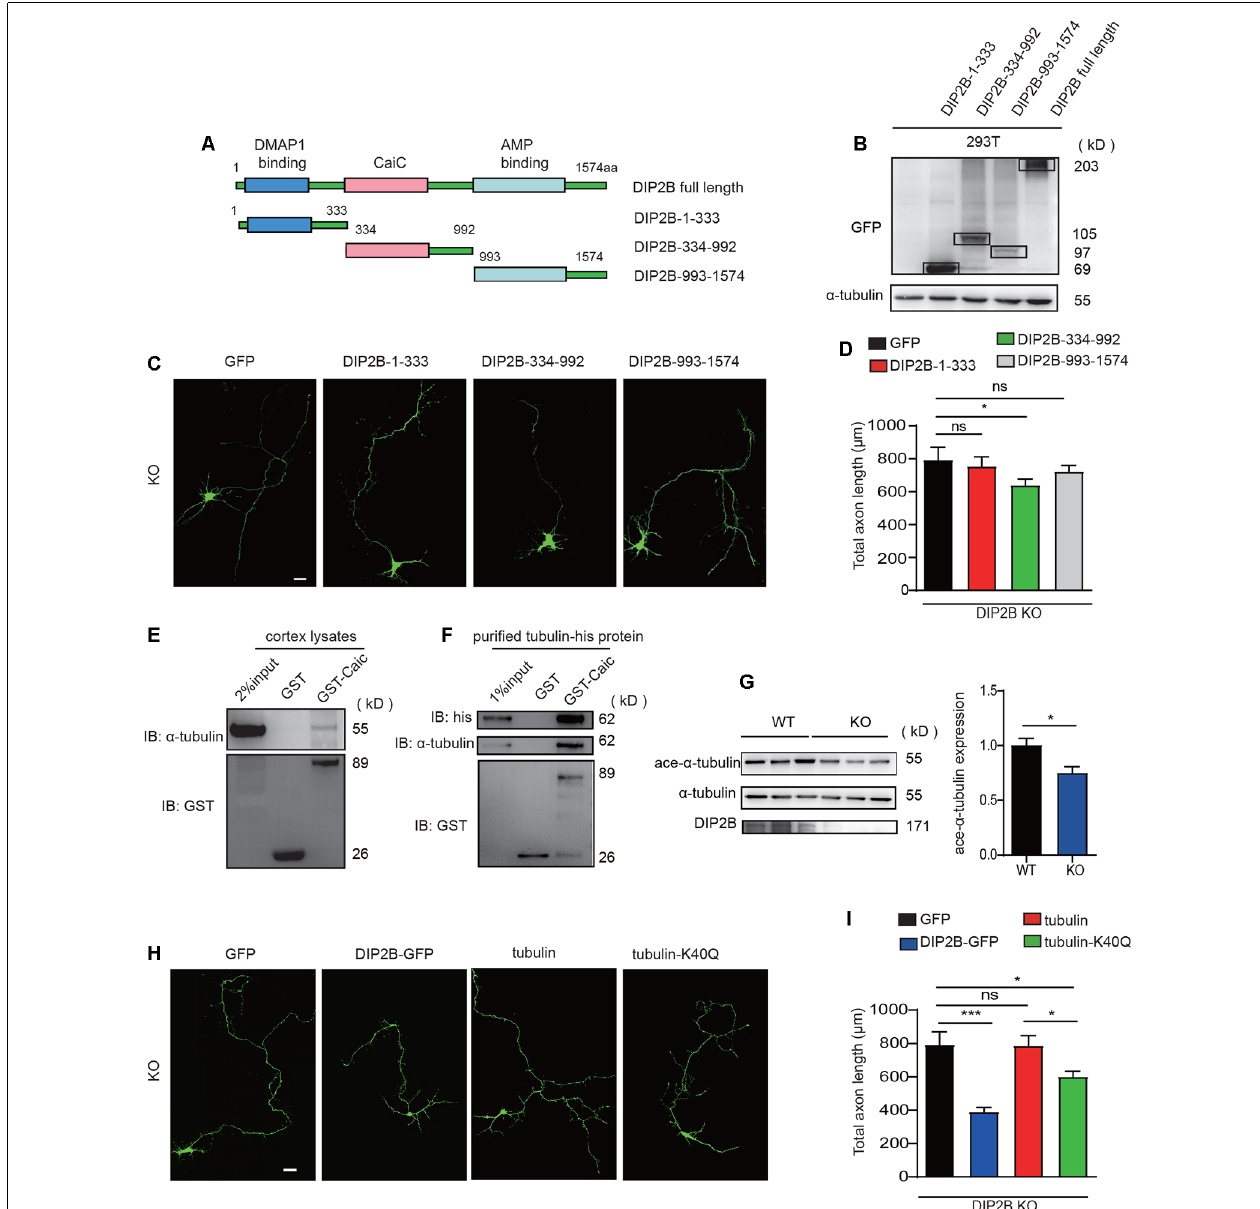
FIGURE 6 | Acetylation of α -tubulin is critical for the regulation of DIP2B during axonal outgrowth. (A) A schematic image showing constructs for different DIP2B domains. (B) Immunoblot (IB) of protein extracts from 293T cells. (C) CaiC domain was critical for DIP2B regulating axon outgrowth (KO+GFP, n = 23; KO+DIP2B-1-333, n = 21; KO+DIP2B-334-992, n = 24; KO+DIP2B-993-1574, n = 23). Scale bar: 20 µ m. (D) Averaged axon shown in (C) . (E) P56 cortical lysates were incubated with the GST-DIP2B-Caic and GST proteins as bait and then evaluated by Western blotting. (F) Purified tubulin was incubated with the GST-DIP2B-Caic and GST proteins as bait and then evaluated by Western blotting. (G) Immunoblot analysis exhibited that α -tubulin acetylation was decreased in DIP2B KO mice. n = 6, data came from two independent experiments. (H) K40Q is critical for DIP2B regulating axon outgrowth (WT, n = 15; KO, n = 16; KO+DIP2B, n = 22; KO + tubulin, n = 23; KO+K40Q, n = 22). Scale bar: 20 µ m. (I) Average total axon length from panel (H) . One-way ANOVA was used for comparisons. ns, not significant; * p < 0.05, *** p < 0.001; n, cell number. Error bars represent SEM. For further details, see Supplementary Table S1 .